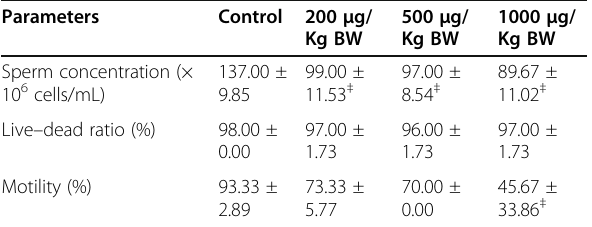
Table 2 Effect of hexane fraction of Waltheria indica Linn . root on sperm parameters of male Wistar rats (Mean ± SD, n = 5 for each group)